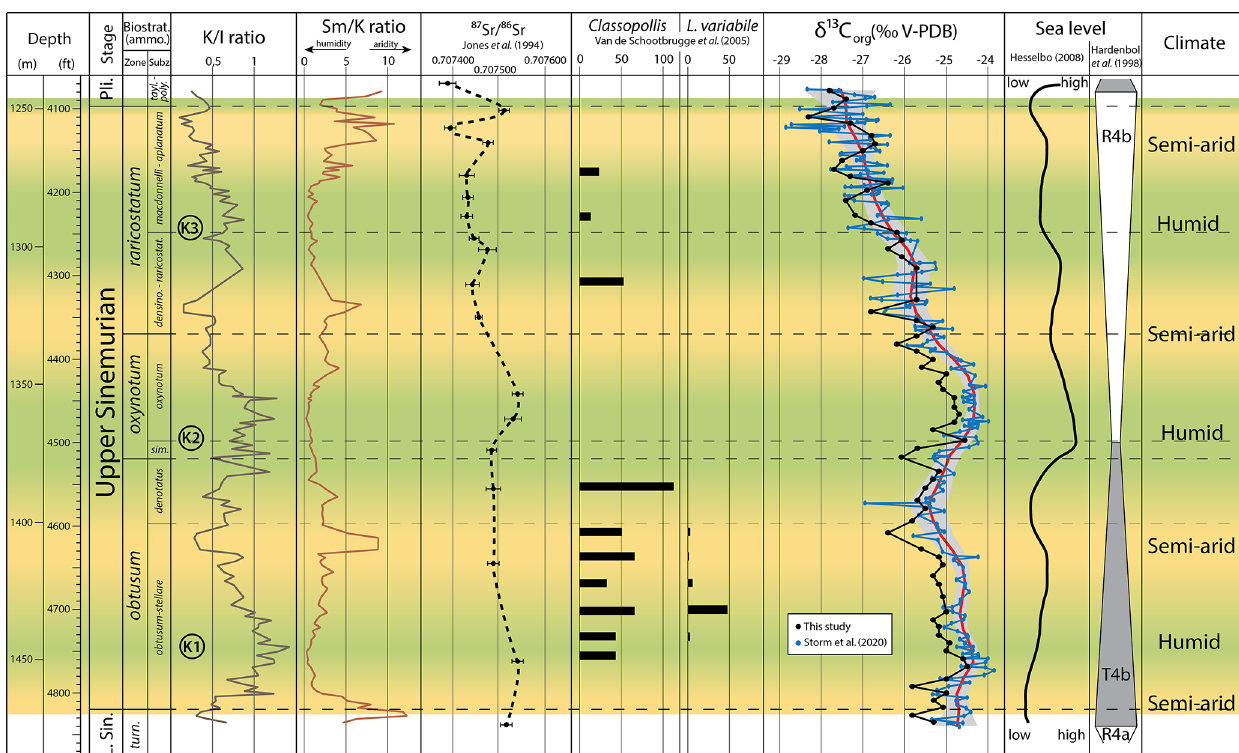
Figure 11. Palaeoclimatic interpretations inferred from clay mineral assemblages expressed by K / I and Sm / K ratios compared with Clas- sopollis and Liasidium variabile abundance and strontium isotopes (Jones et al., 1994; van de Schootbrugge et al., 2005; Riding et al., 2013), as well as carbon isotope variations (this study; Storm et al., 2020). Eustatic and/or regional relative sea level variations are from Hardenbol et al. (1998) and Hesselbo